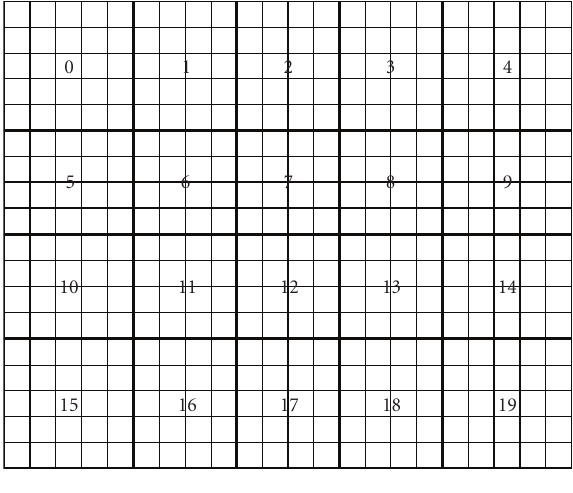
Figure 4: Virtual frame partition.